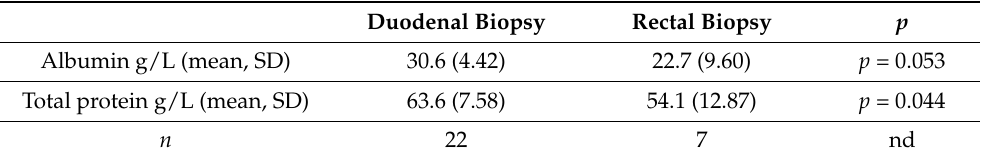
Table 5. Table showing the value of albumin and total